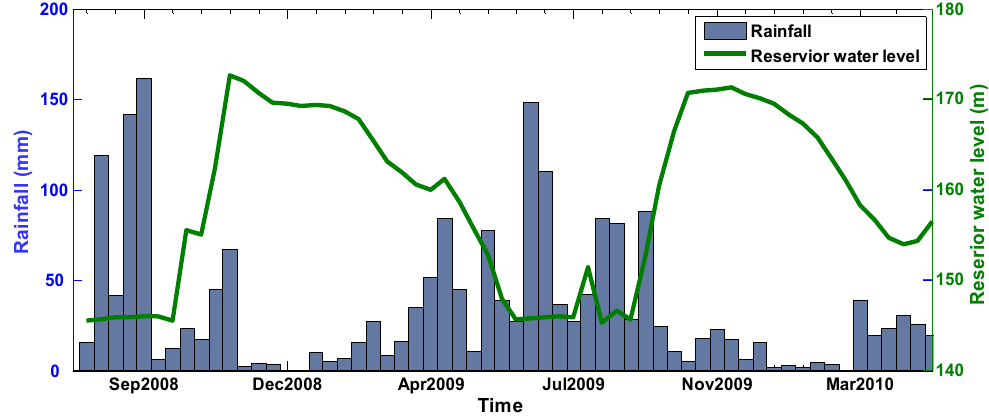
Figure 6. The fluctuations of the synchronous reservoir water level and rainfall.